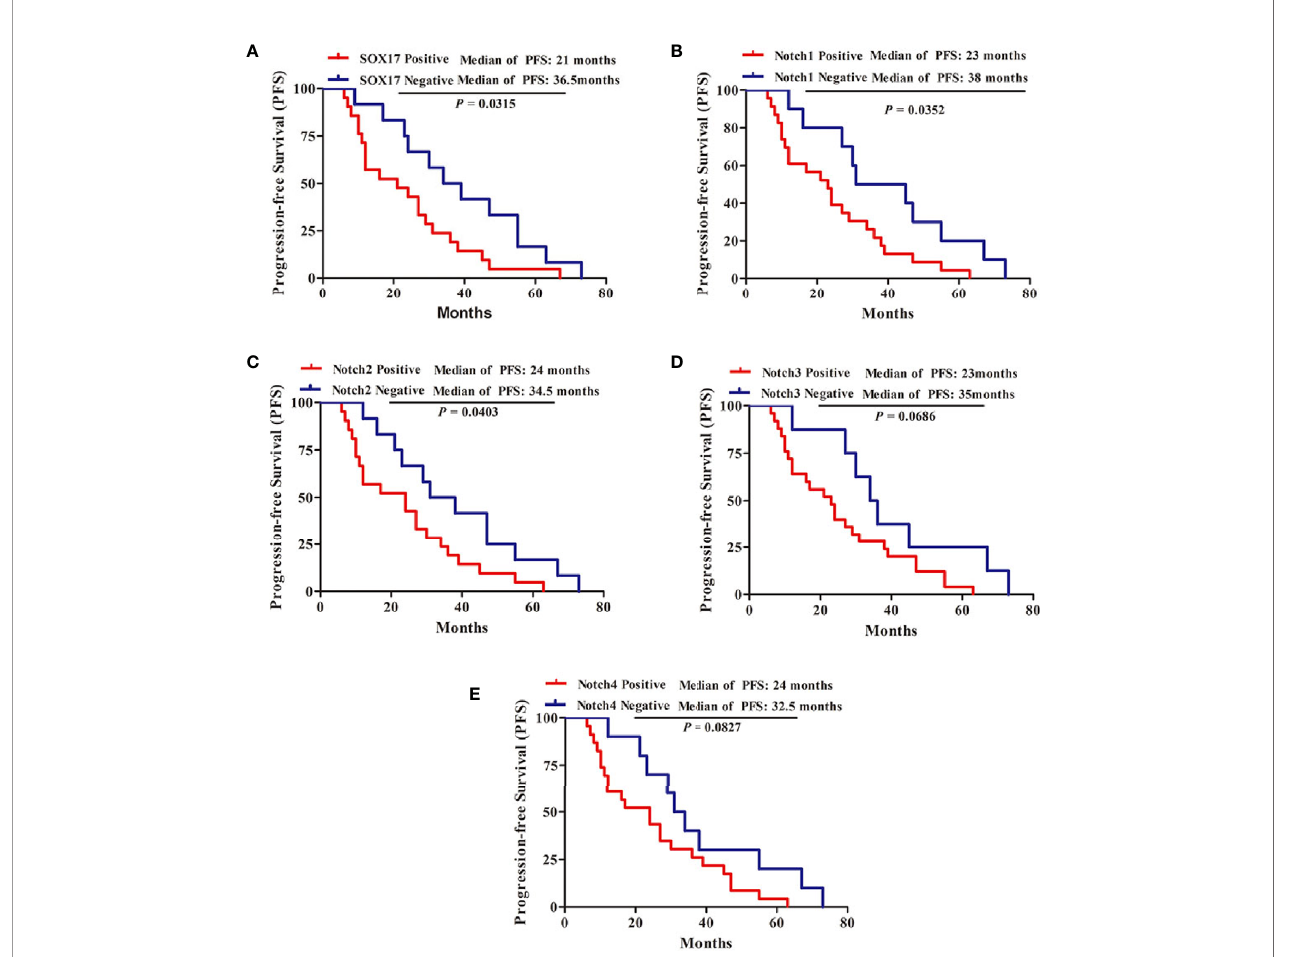
FIGURE 2 | Kaplan-Meier survival analysis for the progression-free survival (PFS) of 33 patients with CRPC. (A) 21 patients with SOX17-positive, 12 patients with SOX17-negative, (B) 23 patients with Notch1-positive, 10 patients with Notch1-negative, (C) 21 patients with Notch2-positive, 12 patients with Notch2-negative, (D) 25 patients with Notch3-positive, eight patients with Notch3-negative, (E) 23 patients with Notch4-positive, 10 patients with Notch4-negative. P < 0.05 was considered statistically signi fi cant.